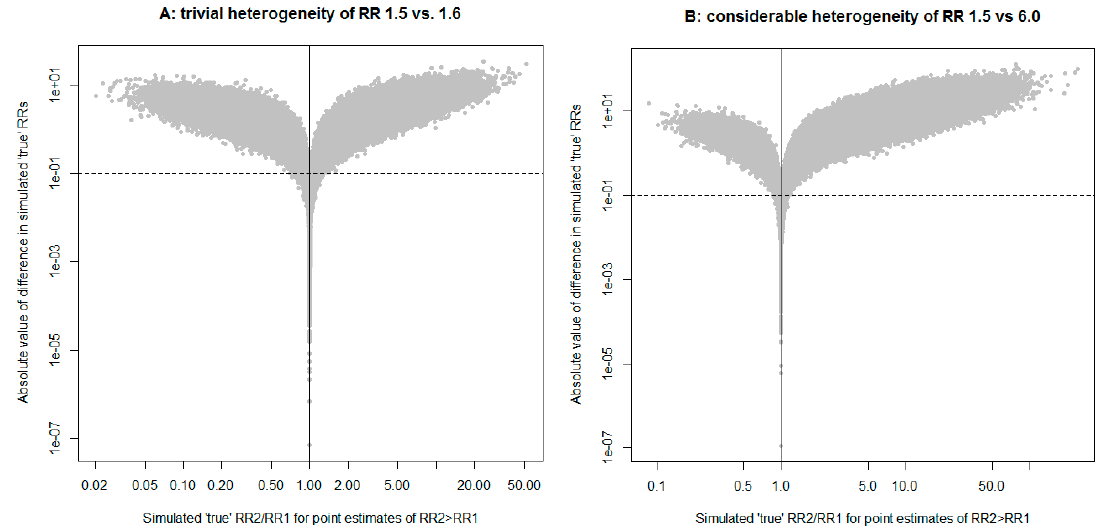
Figure 1. Results of 1,000,000 simulated true rate ratios (RR). When simulated RR are in the same order as point estimates, they appear to the right of solid vertical line; when absolute different in simulated RR is ≥ 0.1, they appear above dashed horizontal line. ( A ) shows a synthetic example that illustrates virtual homogeneity; ( B ) shows a synthetic example that illustrates considerable heterogeneity. Precision is the same in both panels for higher vs. lower point estimate of RR.